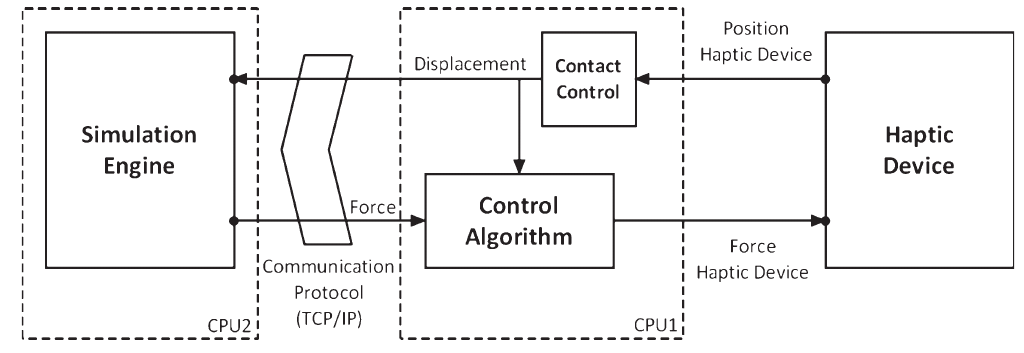
Fig. 10. The virtual environment is divided in two section each working on an independent processing unit (CPU), in the first block in calculated the interaction point of the haptic avatar with the virtual environment and there is block for the control of the haptic device; while the on the second processing unit are solved the calculation of the virtual environment. The two blocks are physically on two different units and are connected with a TCP/IP